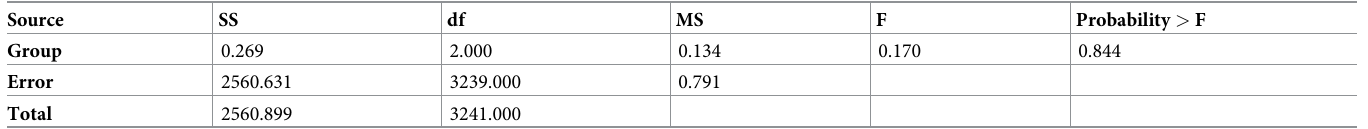
Table 3. One-way analysis of variance for pre-intervention attitudes toward IT innovations ( Q pre ) for future generations (future generations). Source